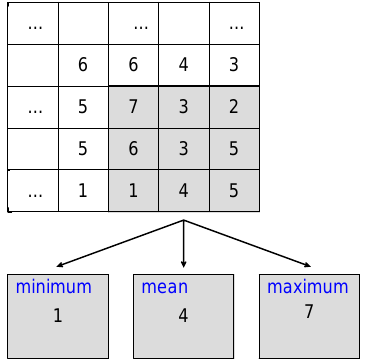
Fig. 4. Illustration of coarse-graining modes of the elevation model employing minimum, mean, and maximum. For an aggregation of 3 × 3 grid cells in the DEM (top) an example of the different result- ing cell values (bottom) is displayed (with exemplary numbers).